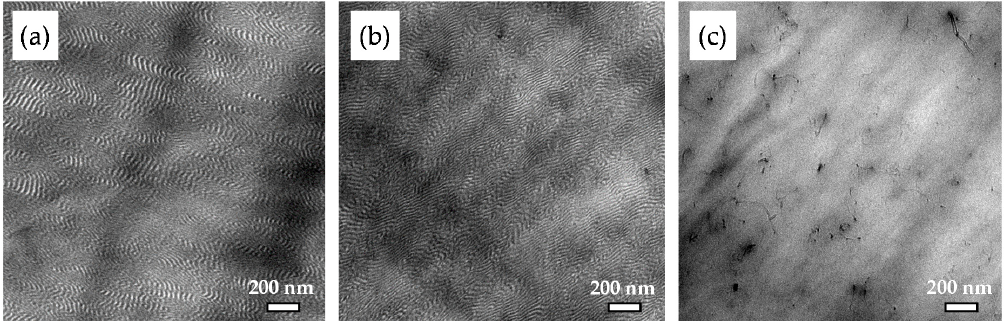
Figure 3. Morphology images from TEM of ( a ) LN3_A, ( b ) LN3_1_A, and ( c ) multiwalled carbon nanotubes (MWCNT) dispersion, in LN3_1_A (non-contrasted sample) .